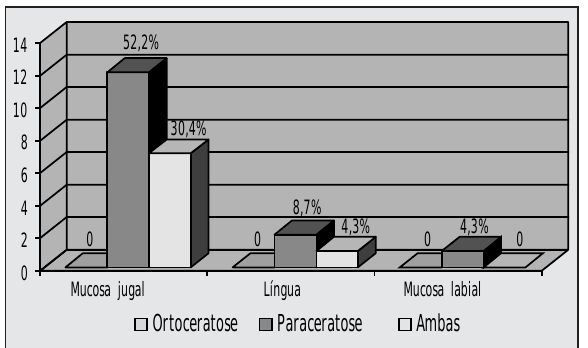
Figura 7 – Avaliação da hipergranulose em cunha em 59 biópsias de líquen plano cutâneo e oral (com e sem ceratinização normal)